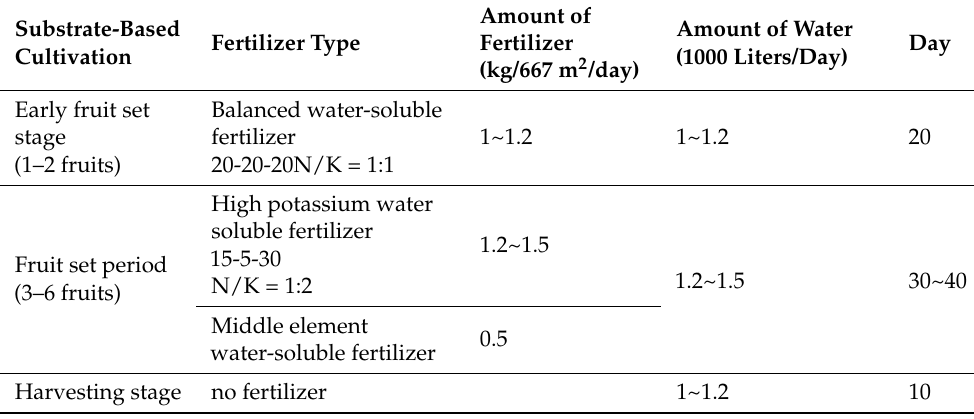
Table 2. Fertilizer and irrigation scheme in the